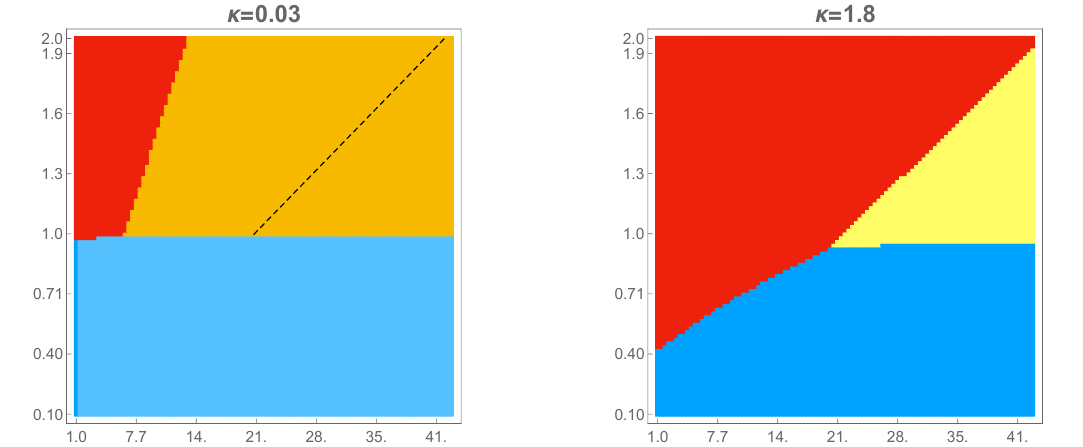
Figure 11 . Phase diagrams of a very light (left) and a very heavy (right) domain wall between degenerate vacua ( b = 1 ). The horizontal and vertical axes are γ and τ . The broken line in the left diagram separates solutions of type [H1, E2 0 ] and [H1,E2] that only differ in the sign of the energy of the horizonless slice. The color code is as in figure 6.